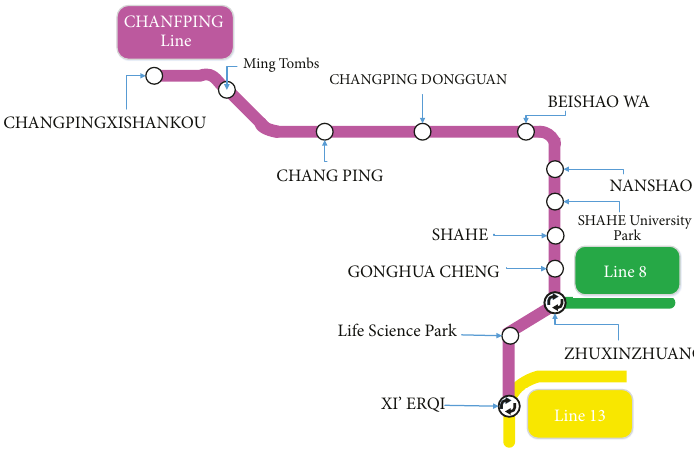
Figure 3: Illustration of the Changping Line. Table 2: Overview of measurement